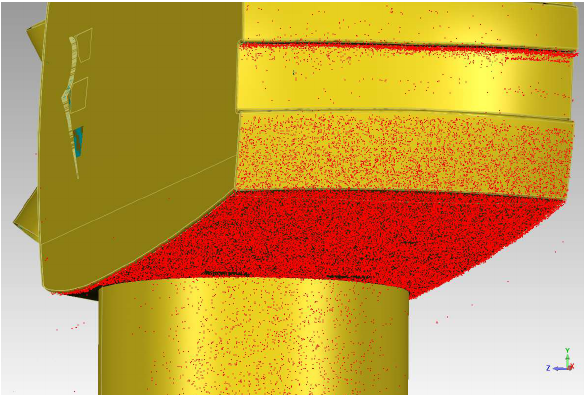
Figure 6. Point cloud of 3D scans combined with a CAD